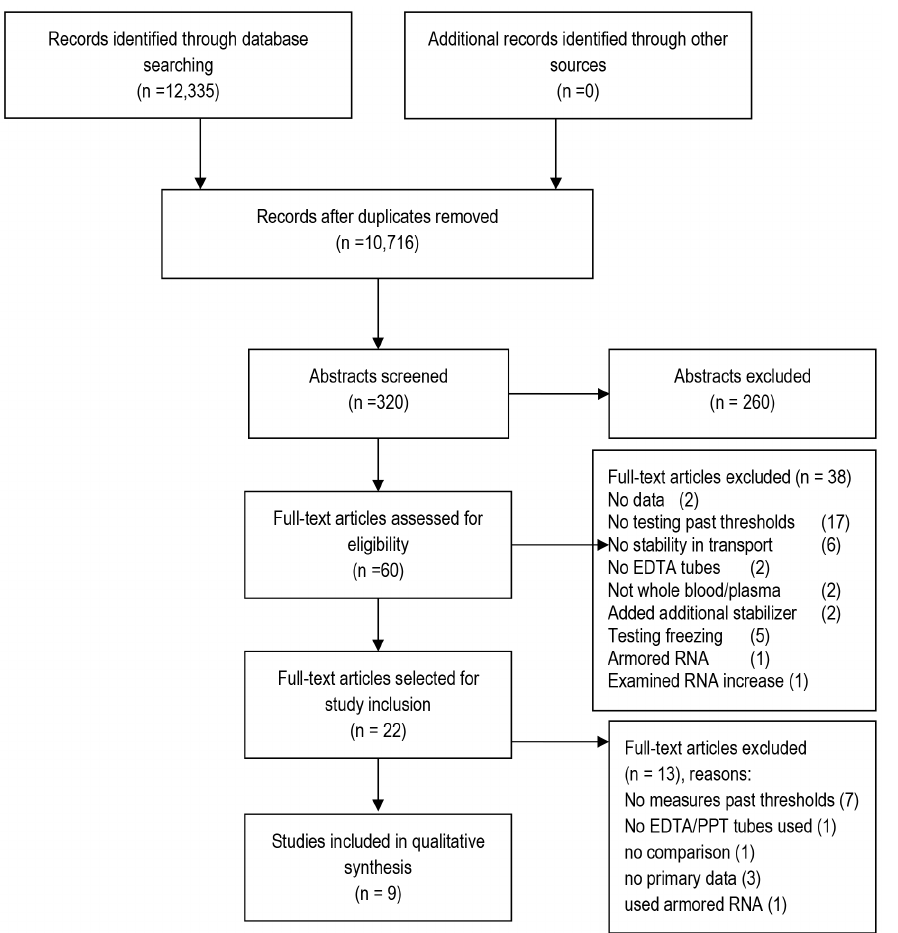
Figure 1. Search